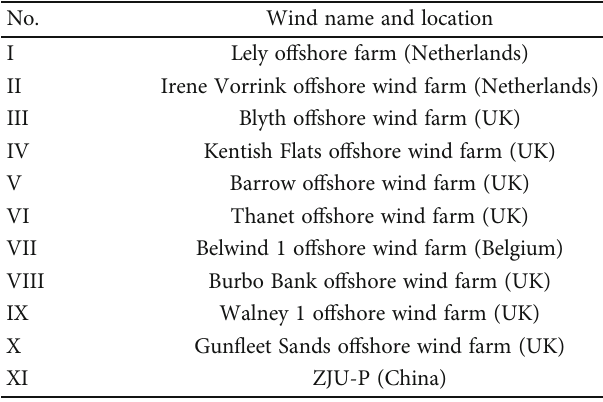
Figure 3: Mathematical model of OWT with three di ff erent forms of tapered tower. Table 1: Name and location of the considered o ff shore wind